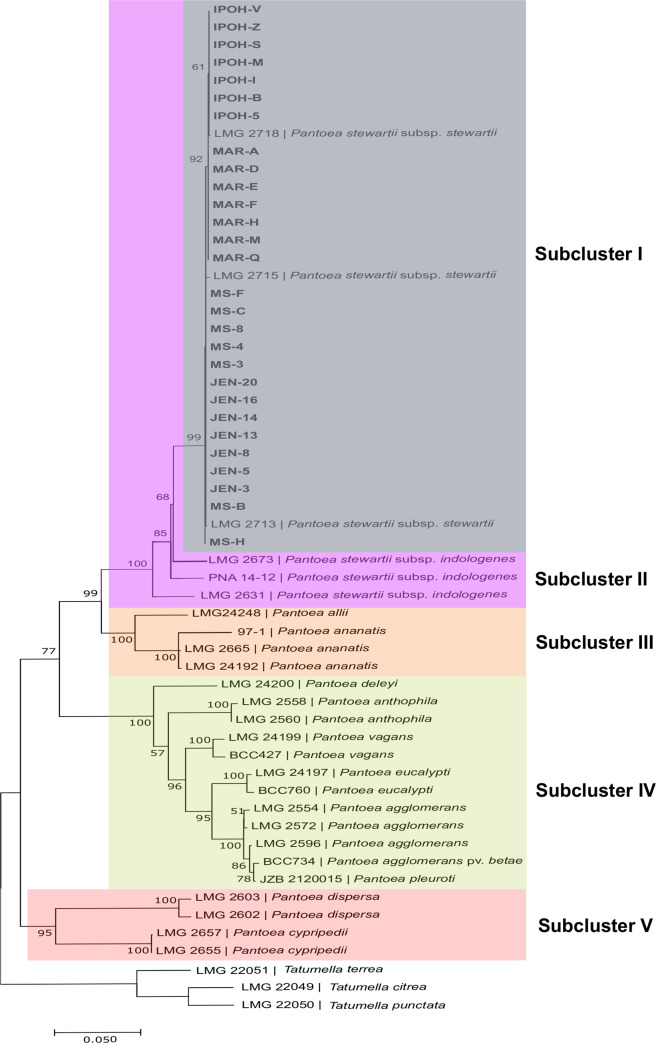
Maximum-likelihood tree based on the concatenated genes (gyrB, rpoB, atpD and infB).Percentage bootstrap values based on 1000 replicates are given at nodes. Tatumella species were included as an outgroup. Bar: 0.05 substitutions per nucleotide position.